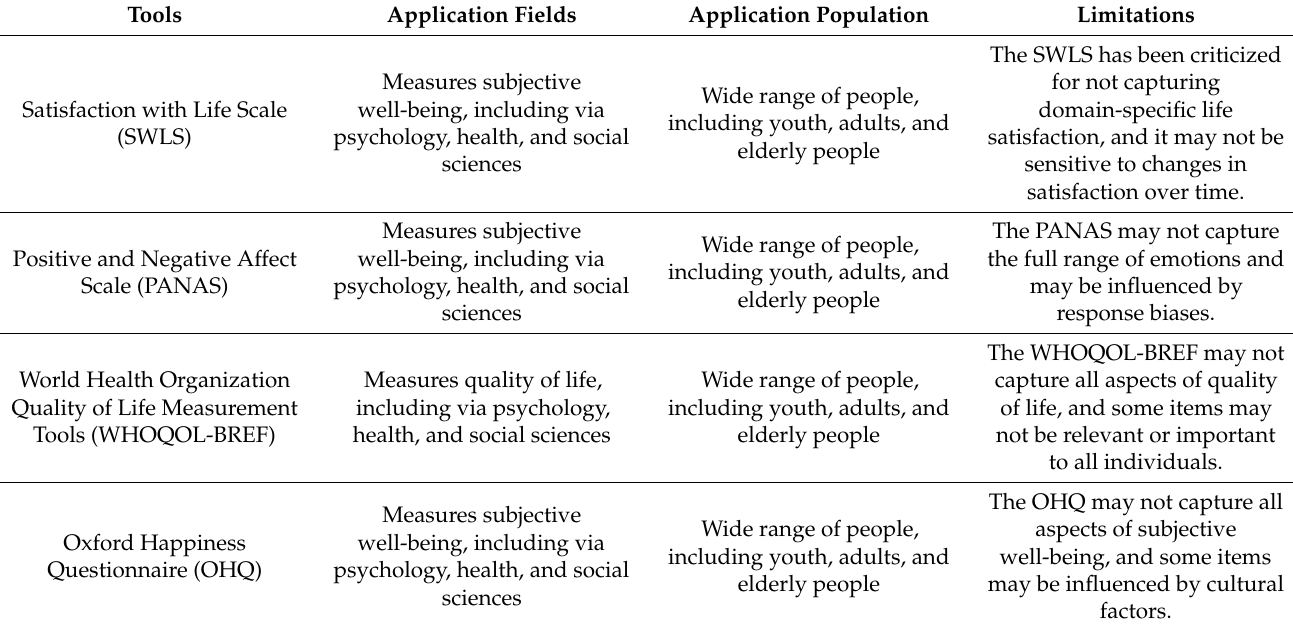
Table 1. Main tools for measuring